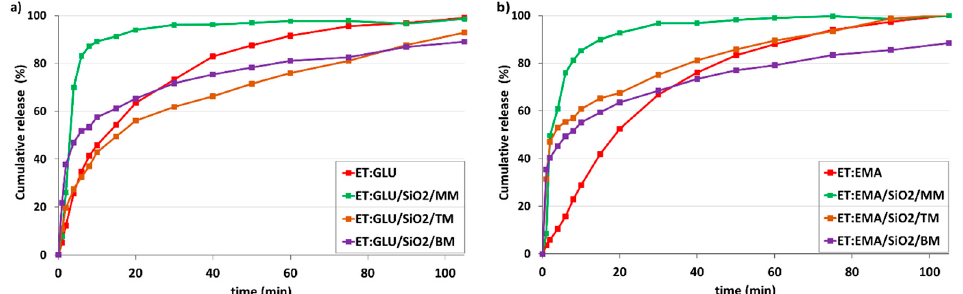
Figure 13. In vitro dissolution pro fi les of ( a ) ET in ET:GLU cocrystal and ET:GLU cocrystal loaded in/on silica SiO 2 , ( b ) ET in ET:EMA cocrystal and ET:EMA cocrystal loaded in/on silica SiO 2 . Samples of cocrystals loaded in/on silica SiO 2 were prepared by three methods as described in legend. Water with pH 5.7 was used as a dissolution medium. The estimated error in measurements was found to be +/ − 1%.